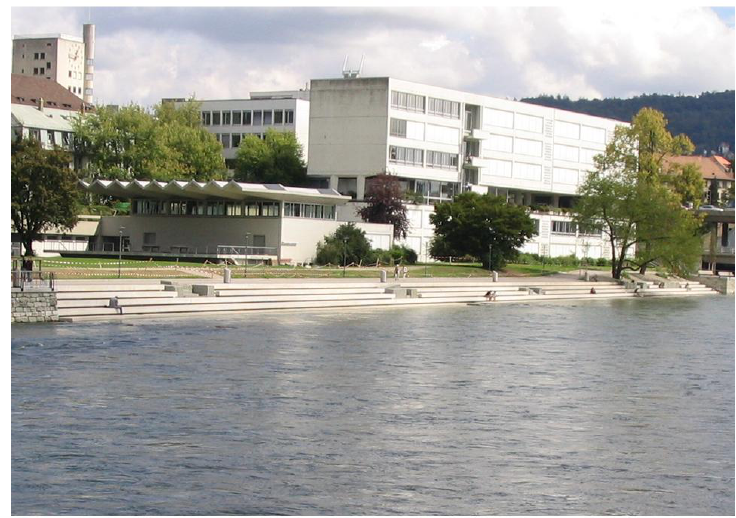
Figure 5b: Modernization of the Limmat river banks in the new Wipkingen Park in Zurich, Switzerland. The intensively urbanized area near the post-industrial site Untere Hard is serving today for recreation. Though the natural environment is suffering from the fashionable spatial changes. The concrete banks made as stairs for people’s comfort are effectively preventing the fauna and flora from using the shore of the water line. The same way, the flood risk, worsening of the river-life conditions, and fragmentation of the wild life in the city are just some of threats for the surrounding (see the theoretical example in Fig. 5a). Nevertheless, at least this example is presenting good access to the public space, as far as the use of the river bank by people is